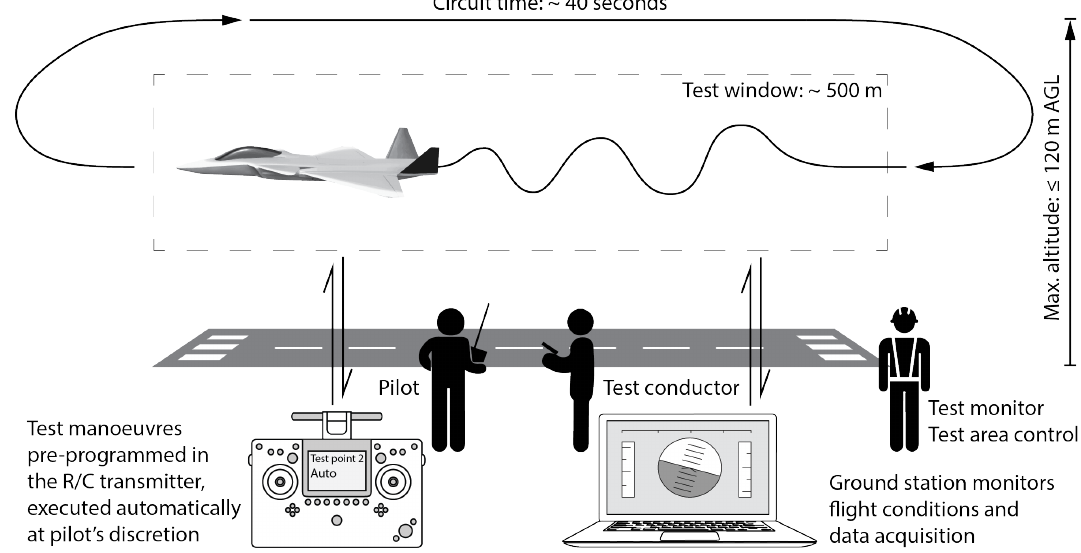
Figure 12. Procedure for flight testing within VLOS. The input signals are injected from the control transmitter using a specially-developed